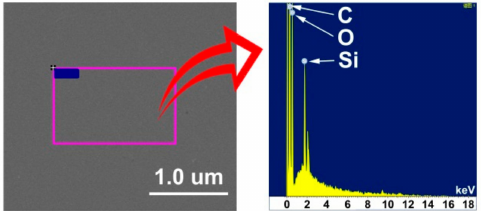
Figure 13. Energy dispersive spectrometer (EDS) images of FPI-25